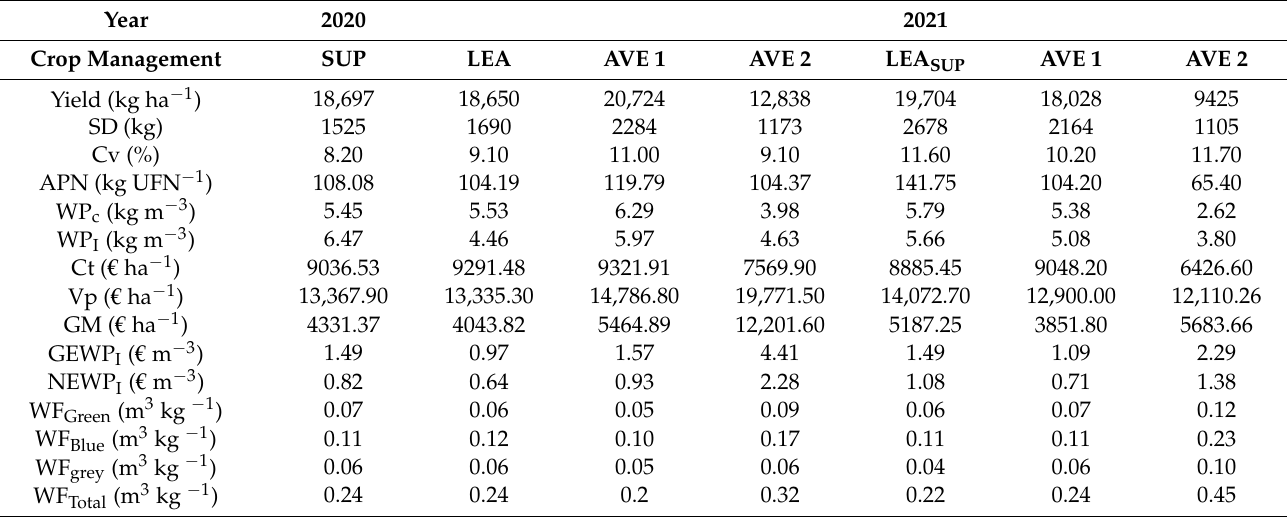
Table 9. Yield and water productivity in the different garlic crop management